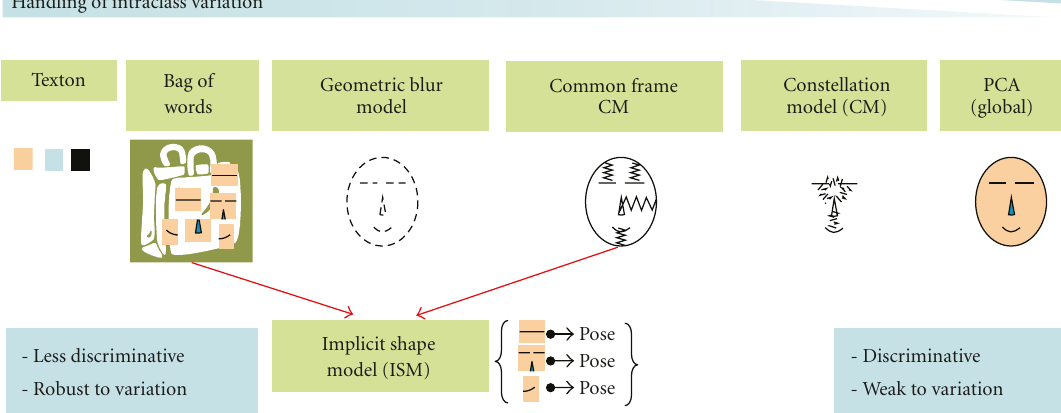
Figure 2: The trade o ff between handling capability of visual variation and object discriminability according to the di ff erent object representation schemes: Global PCA-based object representation uses strong pixel relation, which leads to strong discrimination but weak visual variation. Likewise, texton-based object representation discards pixel relation, which leads to weak discrimination but strong to visual variation.